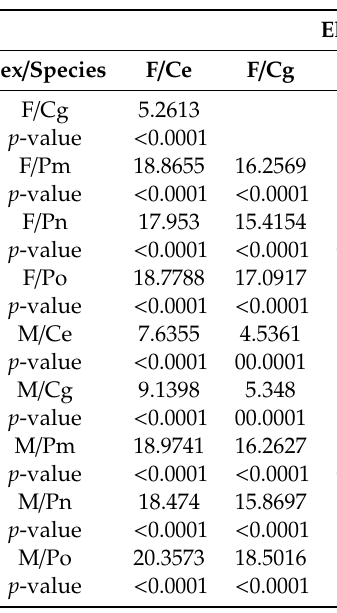
Figure 6. Canonical variate analysis of sexual shape dimorphism, using sex and species as a combined classifier ( A ): ventral view, ( B ): elytral view. Table 2. Mahalanobis distances and the respective p -values of the pairwise permutation, for the elytral view comparison of sexual shape dimorphism using sex and species as a combined